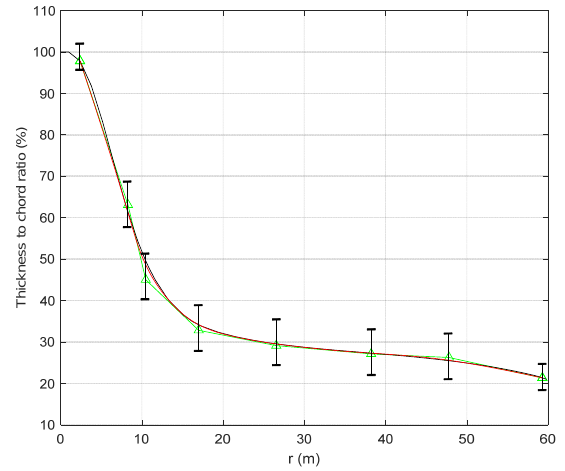
Figure 4. Thickness distribution of the blade.